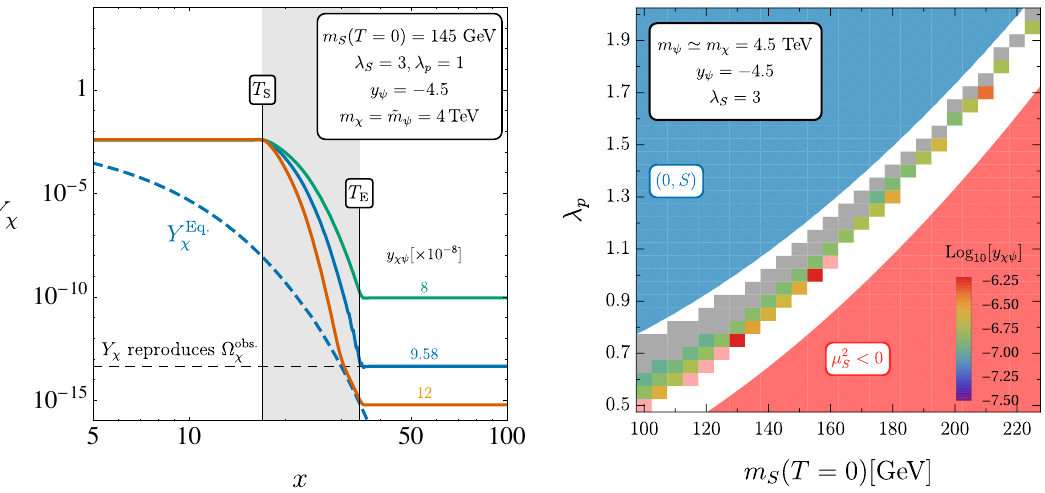
Figure 13 . Left: the evolution of the yield for di(cid:11)erent values of y (cid:31) . Right: the y (cid:31) required to produced the observed relic abundance in the (cid:21) S - m S ( T = 0) plane. In the red region S does not obtain a vev, while in the blue region electroweak symmetry is not broken at T = 0. The grey pixels show where freezes-out before T E while at the pink pixels the equilibrium abundance of (cid:31) at T E is too large for Y (cid:31) to reduce to the observed